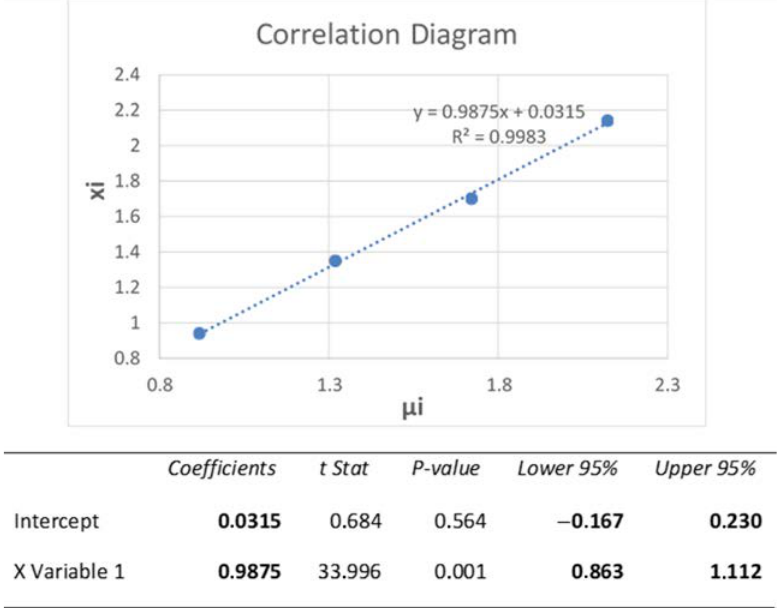
Figure 8. Correlation plot and regression analysis table, to check the accuracy of the method.